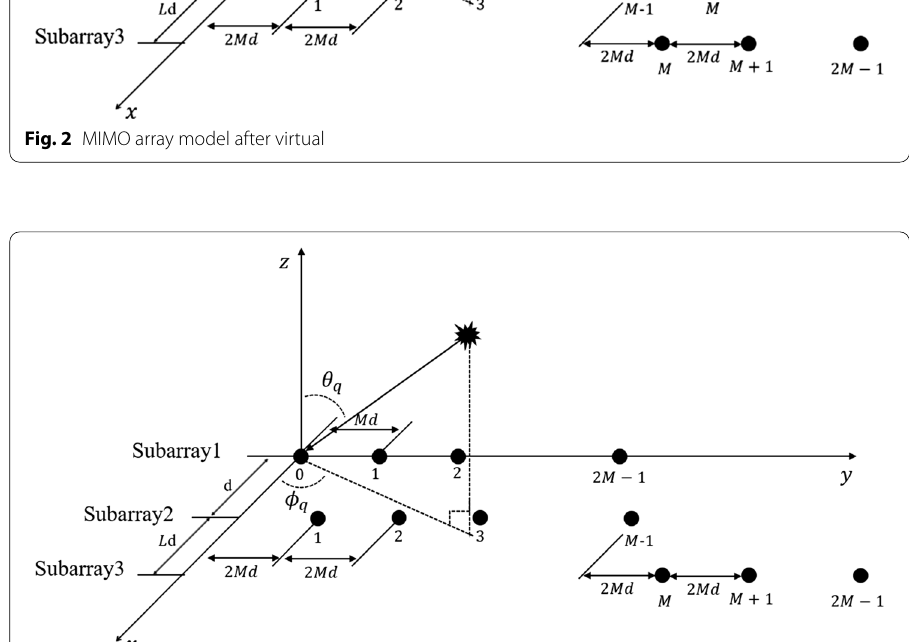
Fig. 3 Virtual post-coprime MIMO